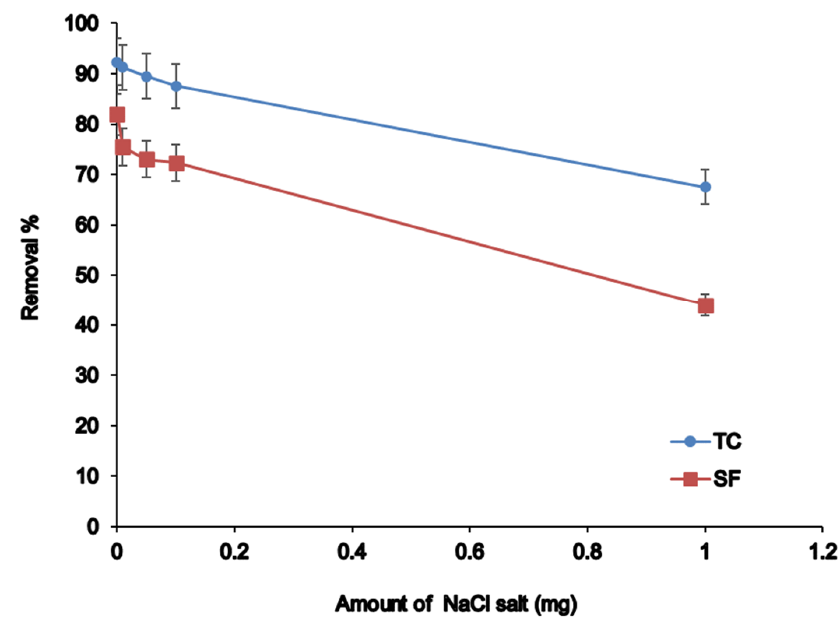
Figure 6. Effect of salt strength on the removal percentage.